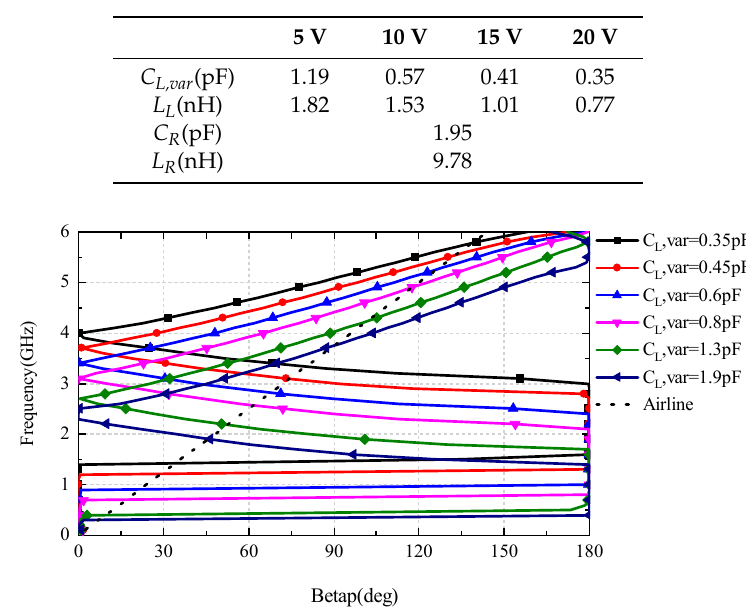
Figure 4. Dispersion diagram of the unit cell with various capacitances of varactors.